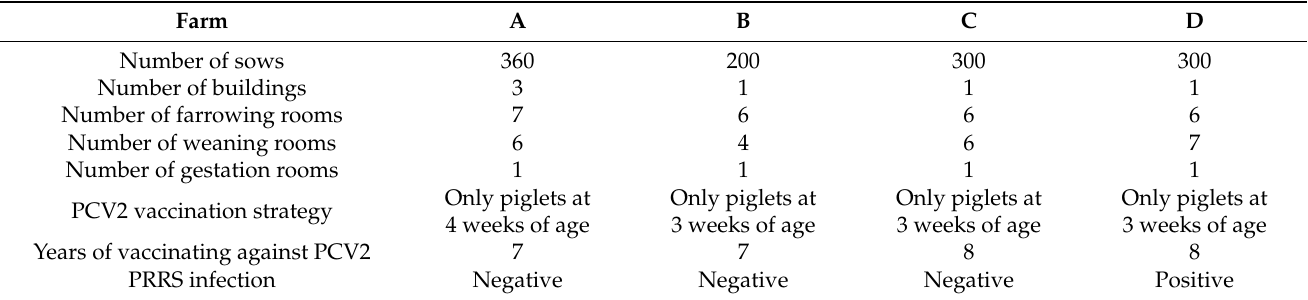
Table 1. Characteristics of the